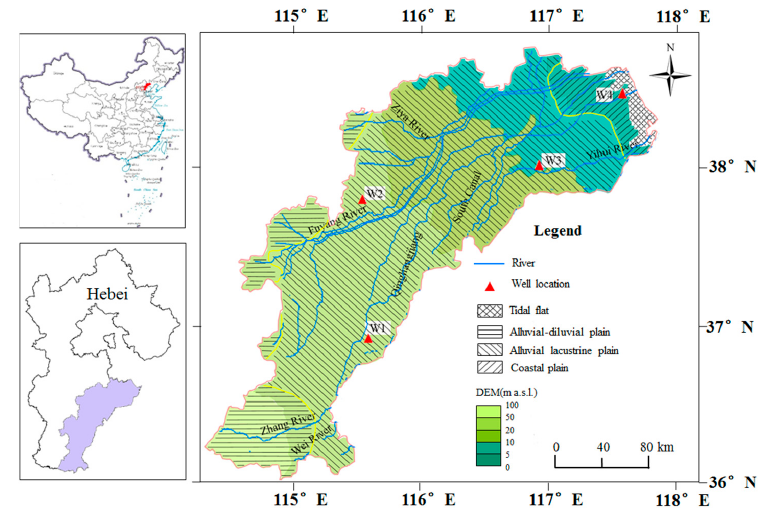
Figure 1. Location of the study area.